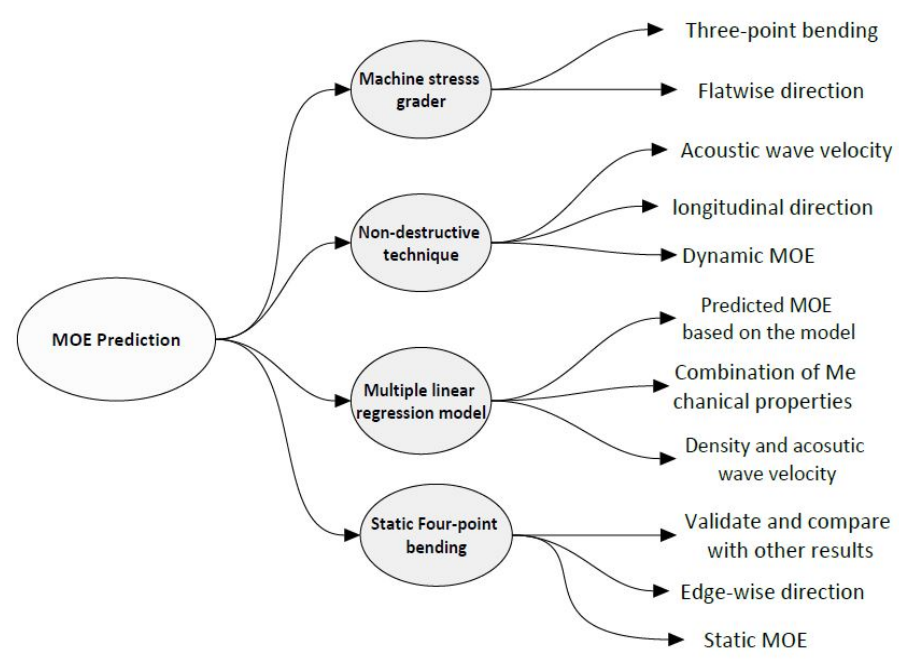
Figure 1. Potential approaches for evaluation of E. nitens timber.